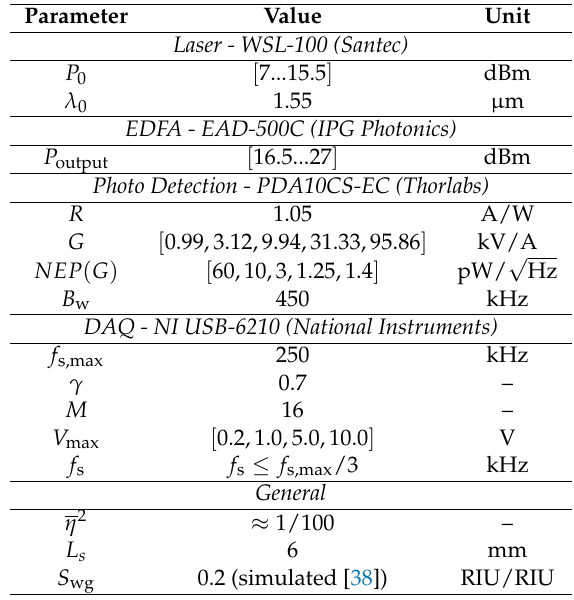
Table A1. Exemplary equipment and parameters for the setup in Figure